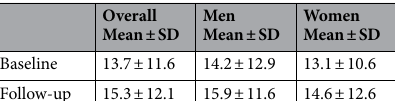
Table 4. Mean maximum cyst size (mm) during both time points; SD = standard